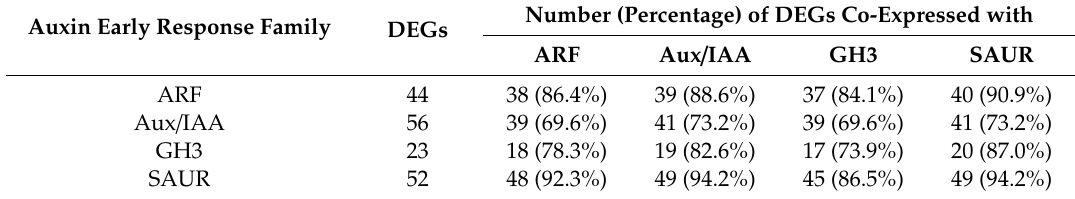
Table 3. Statistics of co-expressed genes among auxin early response families.